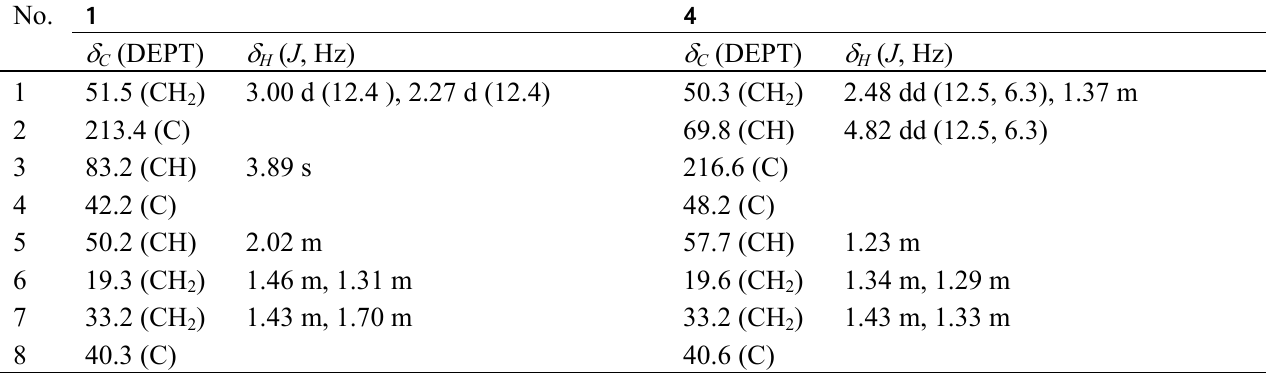
Table 1. NMR data of 1 and 4 in pyridine- d 100 MHz,